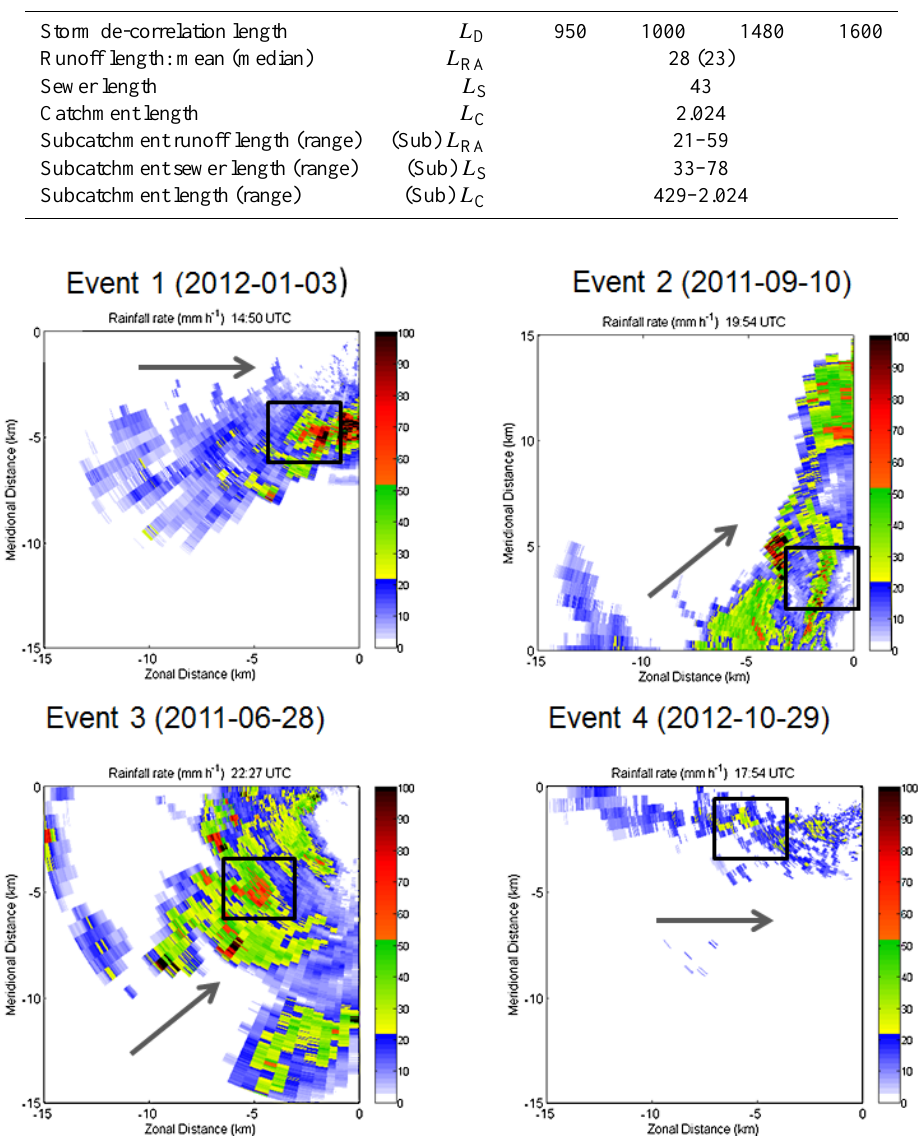
Figure 3. Plots of the maximum intensity time step for the four storm events, main direction of the storm (grey arrow), and virtual position of the catchment with respect to storm movement (black square). Zonal distances in east–west and north–south direction from X-band radar position. The latter is at (0, 0) and the maximum range is 15km. Events 1, 3 and 4 were detected in the southwestern quadrant of the radar coverage, while Event 2 was detected in the northwestern